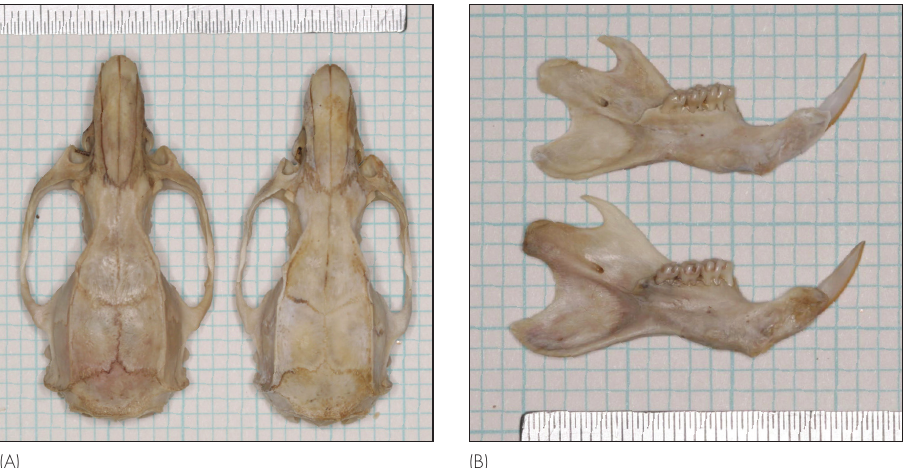
Figure 3. View of de-fleshed skulls: (A) View from above, showing a β 2-agonist only specimen on the left and Denervated only specimen on the right. Note the difference in inter-zygomatic width transverse dimensions. In the Denervated specimen, there is also a slight skeletal asymmetry towards the experimental (left) side. (B) Left hemi-mandibles from a Denervated specimen (above) and a β 2-agonist only specimen (below). Note the difference in size of the angular process and the condyle, the total height of the ramus, and the lower ramus height between the two